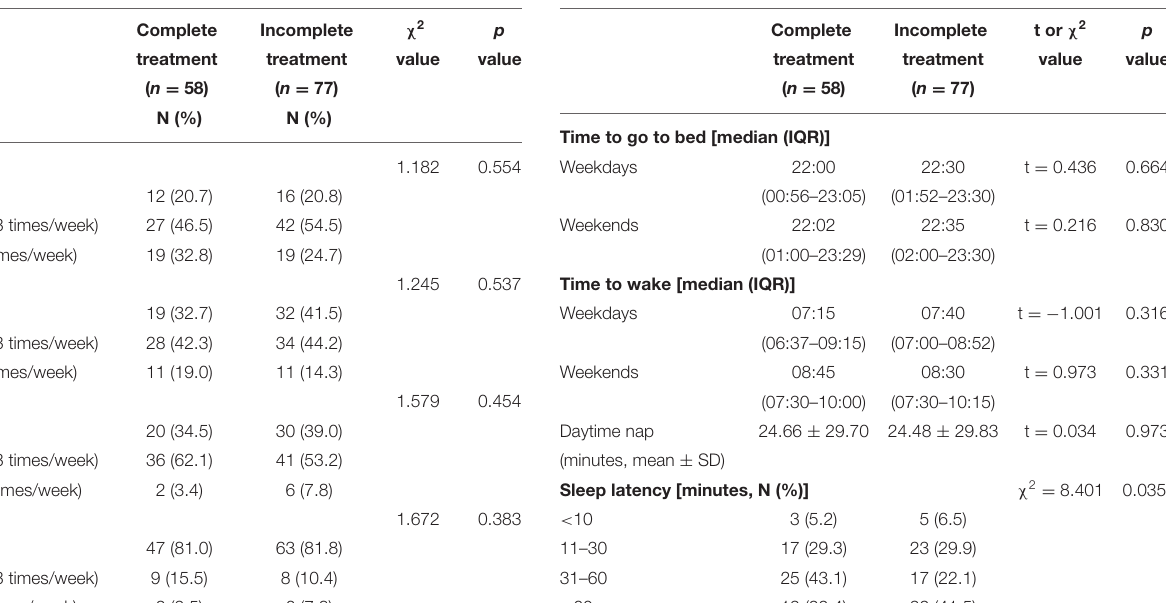
TABLE 2 | Uses of tea, coffee, alcohol and cigarettes in the past year.